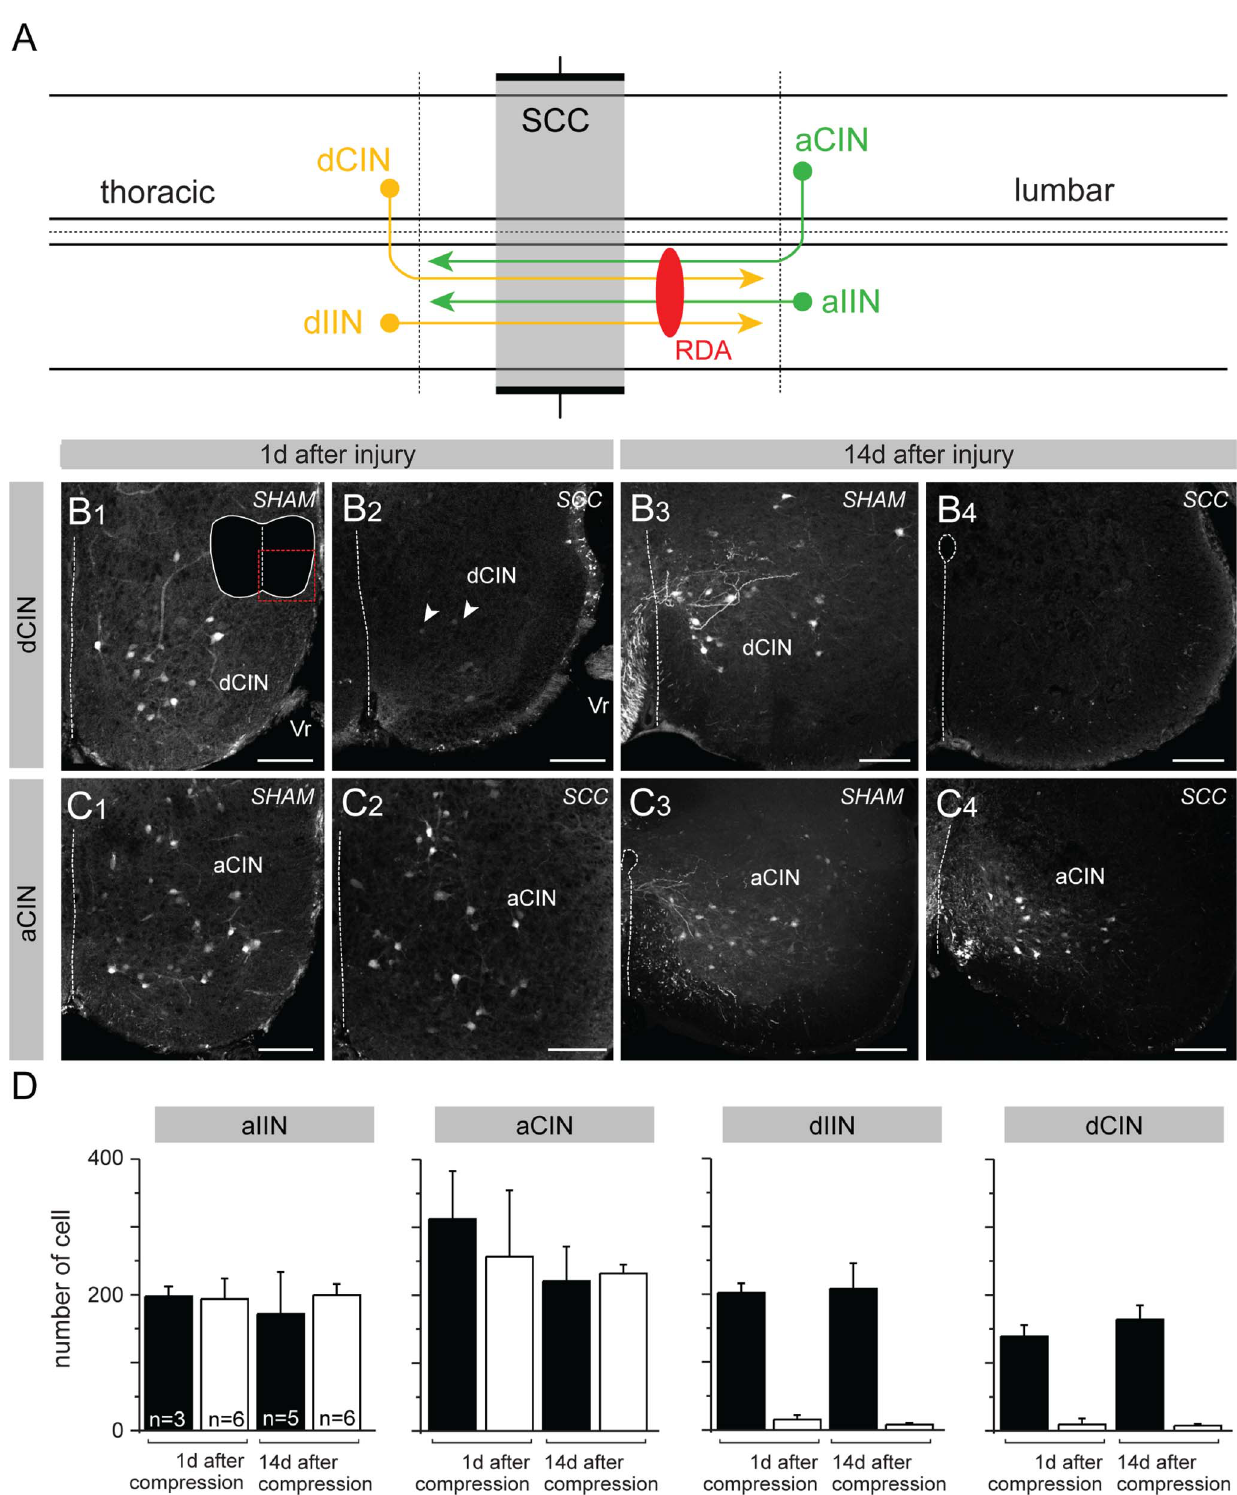
Figure 4. Loss of spinal neurons with descending axons traversing the injury following SCC. (A) Schematic representation of interneurons, propriospinal neurons and projection neurons in the spinal cord based on [34]. The compression was performed in the lower thoracic cord (T10–12, grey area). RDA was applied one segment below the compressed region to label ascending (a) and descending (d) ipsilaterally (I) and contralaterally (C) projecting neurons (INs). (B and C) Representative confocal images of one side of the ventral region of transections containing RDA- labeled dCINs (B) and aCINs (C) in one sham and one SCC mouse 1 day (B1–2, C1–2) and 14 days (B3–4, C3–4) after surgery/injury. Very few are labeled in SCC (arrows, B2) compared to sham controls (B3). The inset in B1 shows the contour of the entire section with the imaged area indicated by the stippled red square. (D) Counts of labeled neuronal profiles of the indicated projection types within a 1 mm stretch of spinal cord immediately